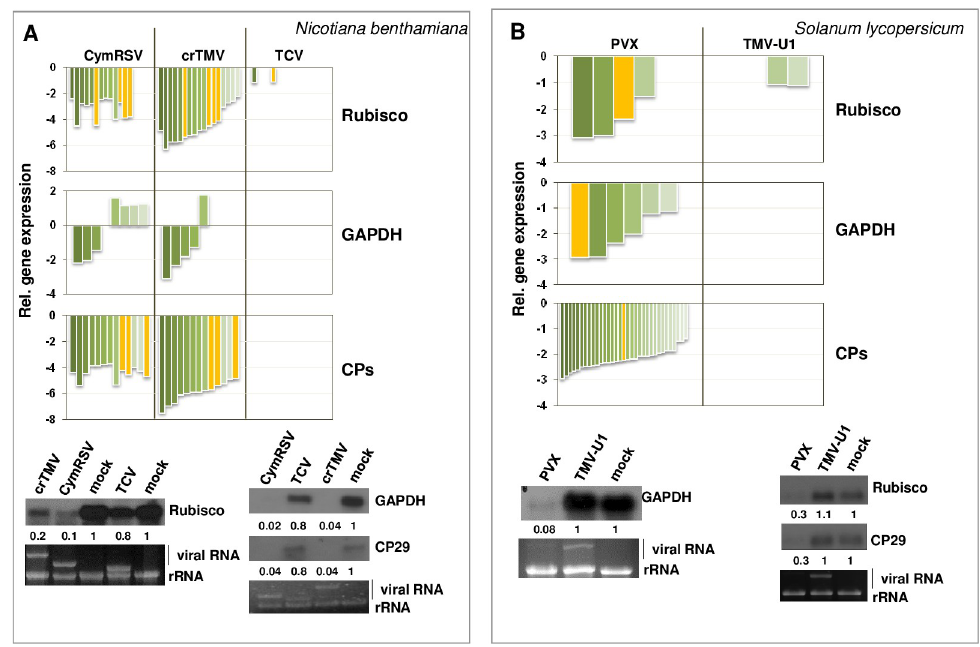
Fig 3. Investigation of the gene expression changes of Rubisco, GAPDH and different chlorophyll binding proteins (CPs) in virus-infected N . benthamiana (A) and S . lycopersicum (B) plants. The column diagram in the upper panel shows log2-fold changes of probes or genes specific for the investigated gene obtained by microarray analysis ( N . benthamiana ) or by RNA-seq ( S . lycopersicum ). The lower panel shows Northern blot hybridization using radioactively labelled probe specific for endogenous genes. Fold-change values are shown below each band (quantifications were normalized to mock controls). EtBr-stained gel served as a loading control. Yellow columns depict genes whose levels were validated by Northern blot hybridization. (The investigated N . benthamiana GAPDH probe was absent on the microarray